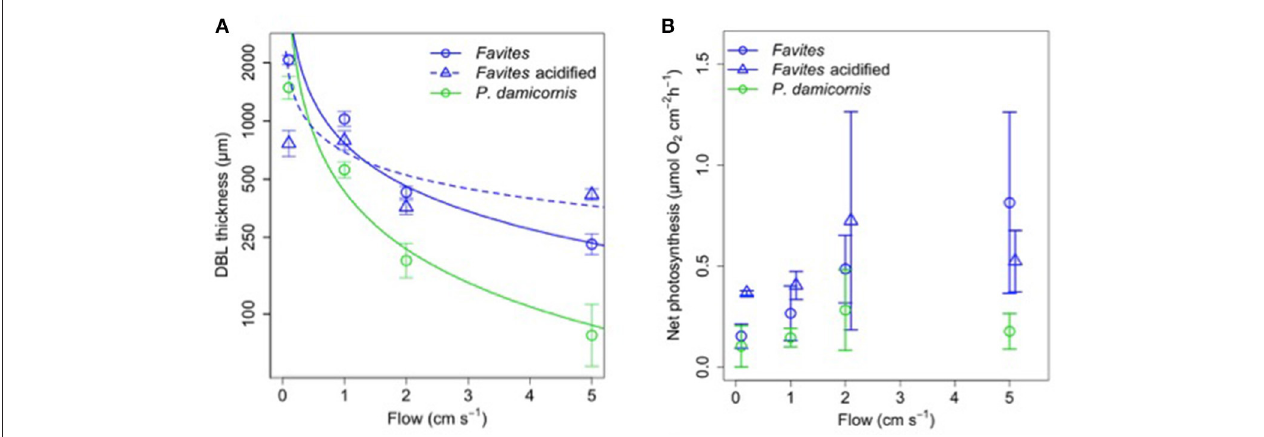
FIGURE 1 | (A) DBL thickness ( µ m) vs. flow (cm s − 1 ) for Favites (blue circles), Favites under acidified conditions (blue triangles) and P. damicornis (green circles). Symbols and error bars represent the mean ± 1.96*SE ( n = 2–6). Lines represent the relationship between DBL thickness and flow from fitted power functions (blue solid—DBL Favites = 767 flow − 0.738 , blue dashed—DBL Favites acidified = 691 flow − 0.399 , green solid—DBL P . damicornis = 432 flow − 0.99 ). (B) Net photosynthesis ( µ mol O 2 cm − 2 h − 1 ) at various flows (cm s − 1 ) for Favites (blue circles), Favites under acidified conditions (blue triangles) and P. damicornis (green circles). Symbols with error bars represent the mean ± 1.96*SE ( n =